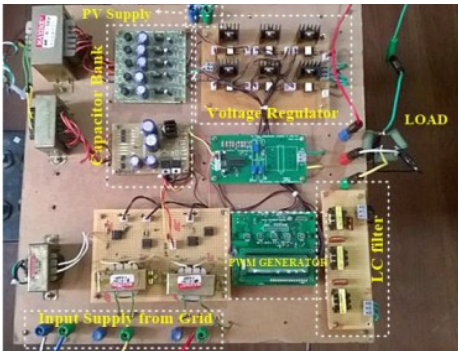
Fig. 10. Hardware Prototype of Proposed Icos Φ algorithm along with Inverter